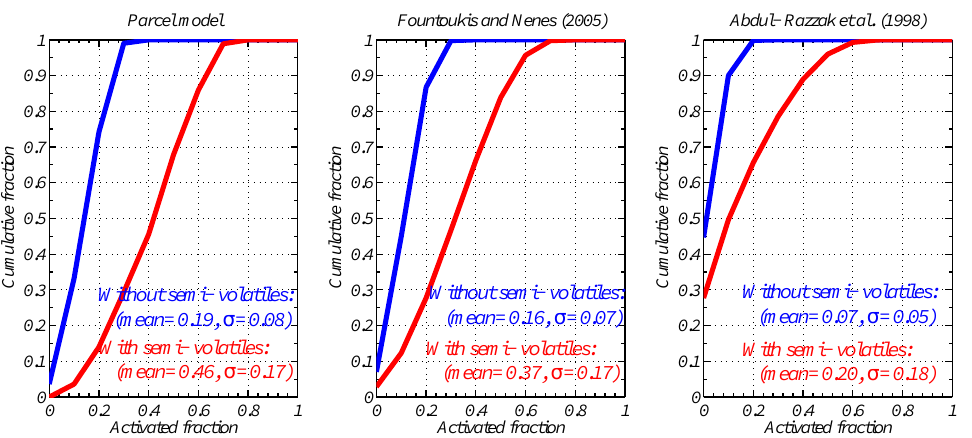
Fig. 11. Cumulative frequency of activated fraction for (i) parcel model simulations (left), Fountoukis and Nenes (2005) implementation (centre) and Abdul-Razzak et al. (1998) implementation (right). Blue is without semi-volatile co-condensation; red is with.